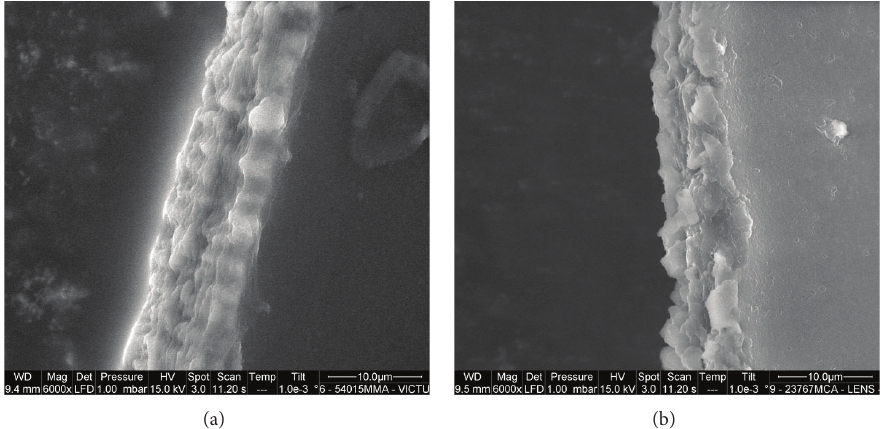
Figure 3: (a), (b) High-magnification images of the Victus and LenSx capsulotomy cutting edges, respectively. The stacks of collagen fibers at the capsular edge could be seen in some specimens (3/5) treated by the Victus FS laser. This was not the case for the LenSx specimens, likely related to a high thermal effect excerpted on the collagen fibers.